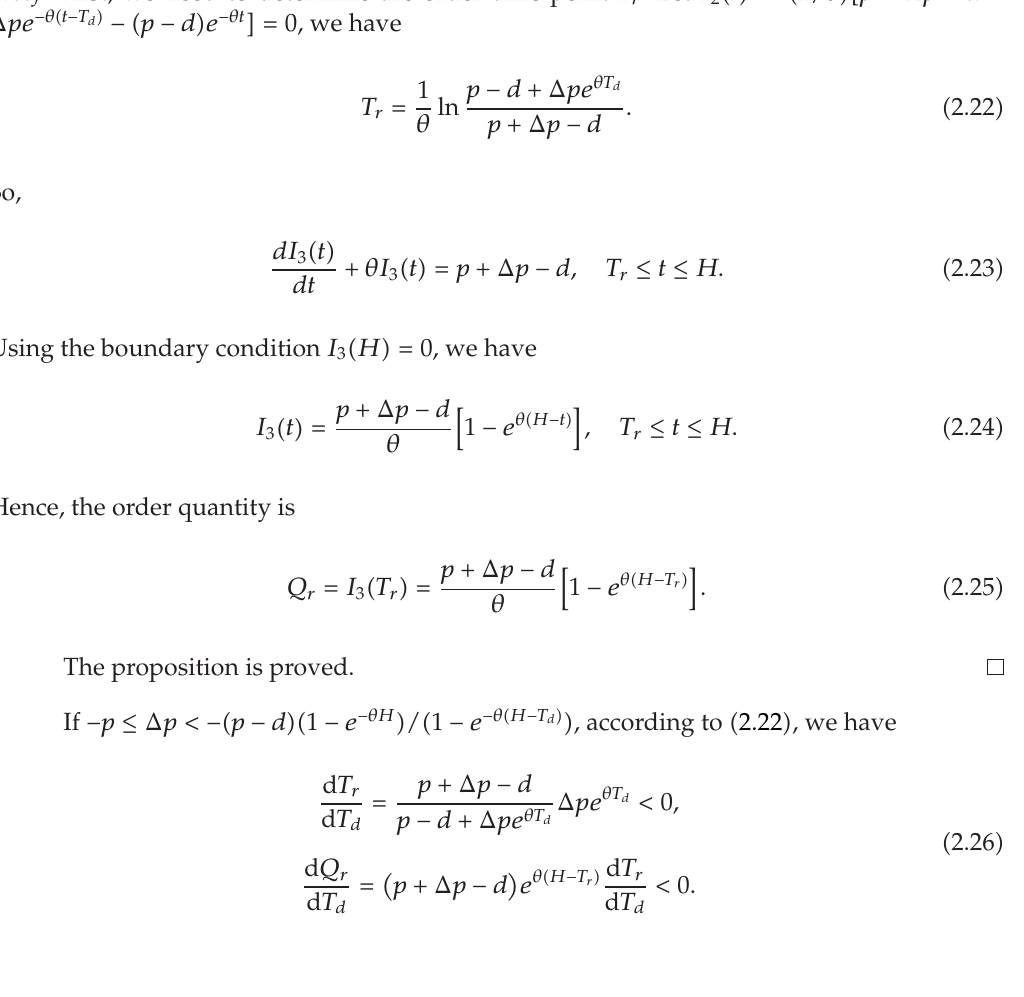
(cid:7) H (cid:6) p